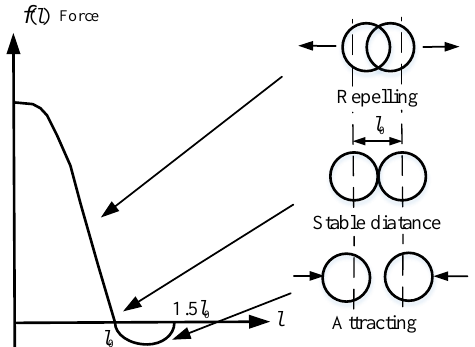
Figure 3. Proximity-based interaction